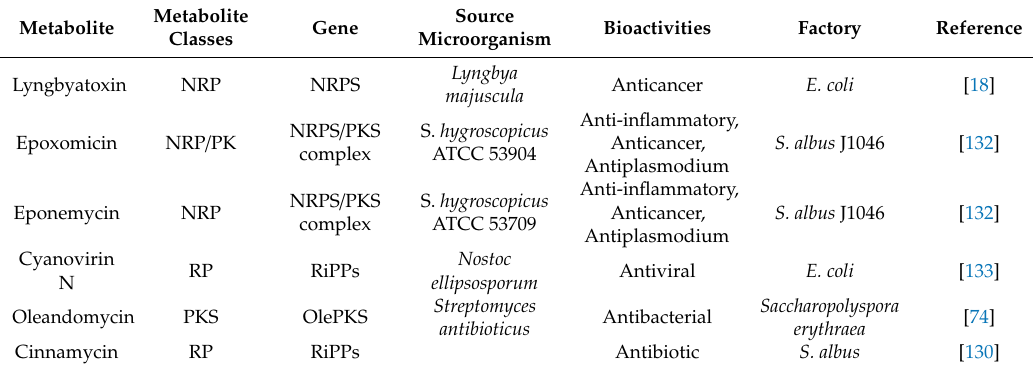
Table 3. Examples of heterologously expressed genes for biosynthetic pathways of selected biologically active compounds from bacteria and